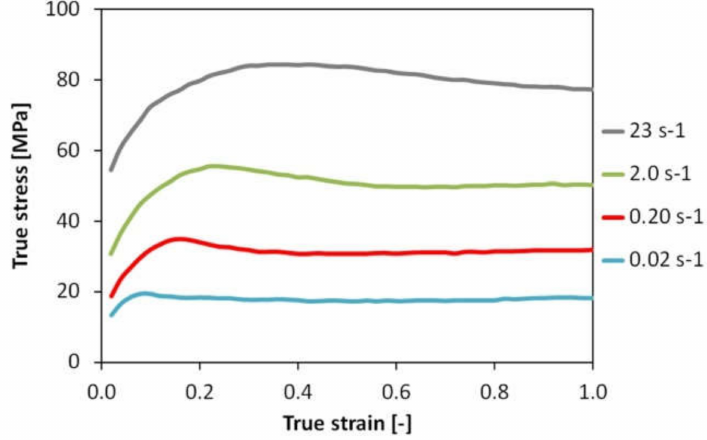
Figure 12. Influence of strain rate on flow curves at a nominal temperature of 1280 ◦ C.